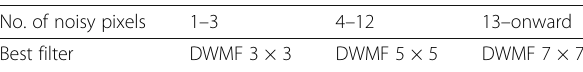
Table 3 Final selected filters for specific range of number of noisy